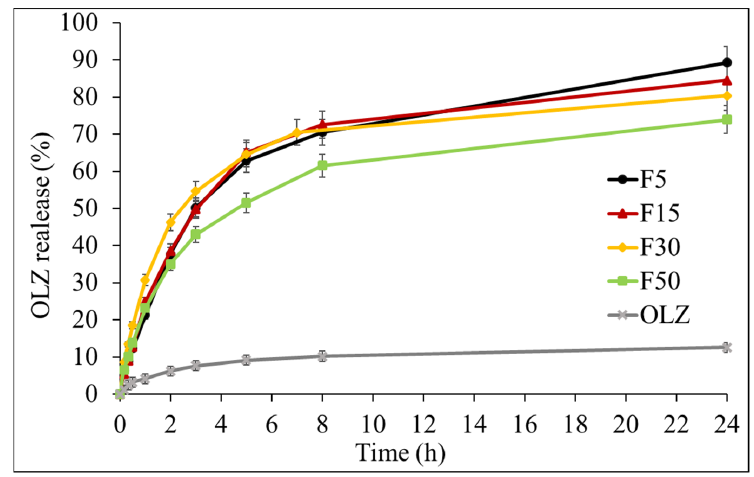
Figure 9. OLZ release kinetics from drug-loaded NLCs and OLZ at 37 °C for 24 h in PBS. OLZ is a BCS class II drug, and its solubility decreases with the increase in pH. The dissolution rate and solubility obtained for OLZ form NLCs was higher than the drug alone. In general, there was a steady and continuous release of OLZ between 0 to 8 h from all formulations. At 8 h, the amount of drug released from F5, F15, F30 and F50 drug- loaded formulations were at 71, 73, 70 and 62%, respectively. An impact of the ratio of liquid lipid was also observed, where increase in Mig in the formulations led to slower and lower drug release, particularly evident for formulation F50 (50% Mig). The highest drug release of 89% was achieved with F5 after 24 h. The OLZ release reduced from 89% from F5 to 74% for F50 NLCs at the end of the experiment. This difference can be attributed to the variations in the particle size of these formulations that resulted in the changes in specific surface area required for diffusion of OLZ from lipid core into the release media [51,52]. Additionally, it is possible that OLZ remains solubilized for longer in formulations containing high ratios of liquid lipid and preferably stays in the matrix for extended peri- ods before being released into the media due to its hydrophobic nature. Therefore, the kinetic data suggests that the NLCs are not only capable of increasing the drug dissolution rate but their liquid lipid content can also influence the release of incorporated drug. The drug release in this work was studied only in pH 7.4 PBS, which provides a general over- view of the release behavior along with the impact of the ratio between solid and liquid lipids as well as the drug content in the formulation. However, it will be appropriate to conduct further studies in simulated gastric and intestinal fluids to understand the influ- ence of variable gastrointestinal conditions on the release of olanzapine from NLCs. Kinetic evaluation of drug release profiles from different NLCs was also performed to understand the mechanisms governing the drug release. The release data were fitted into zero order, first order, Higuchi and Korsmeyer–Peppas models. The calculated cor- relation coefficients (R 2 ) and release exponent ( n ) values are presented in Table 5. Table 5. Correlation coefficients (R 2 ) and release exponent ( n ) values obtained from the different kinetic models for NLCs.